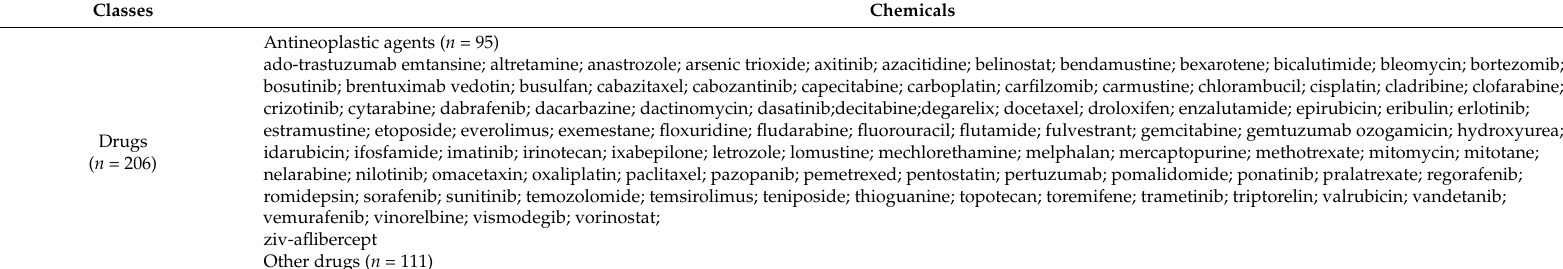
Table 2. High-priority chemical risk